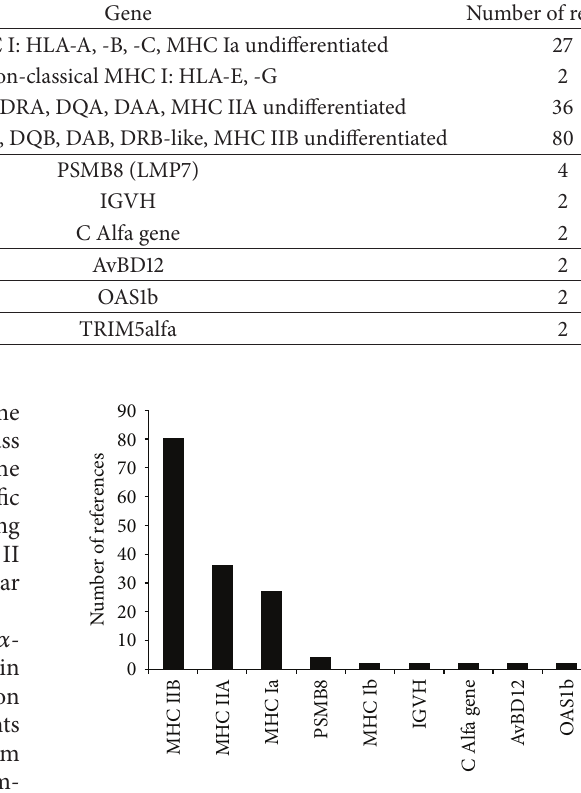
Figure 2: Number of published research articles dealing with TSP in vertebrate immune genes available on Web of Science, final update 19 March 2015. For details see Supplement